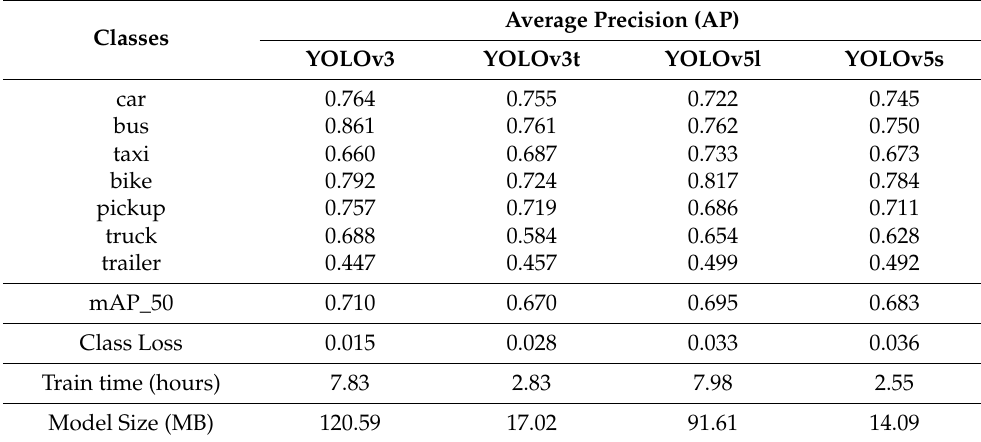
Table 4. Performance of the YOLO networks previously trained on TR1, fine-tuned on TR2, and evaluated on the validation data of